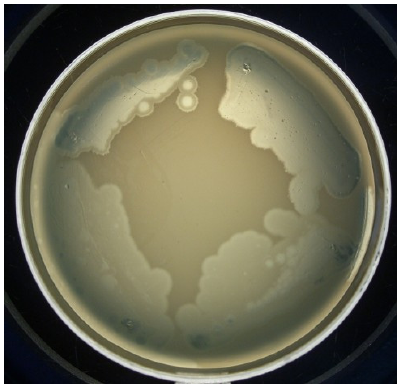
Figure 9. Growth of CHU phage variants on the lawn P. aeruginosa 8–20.